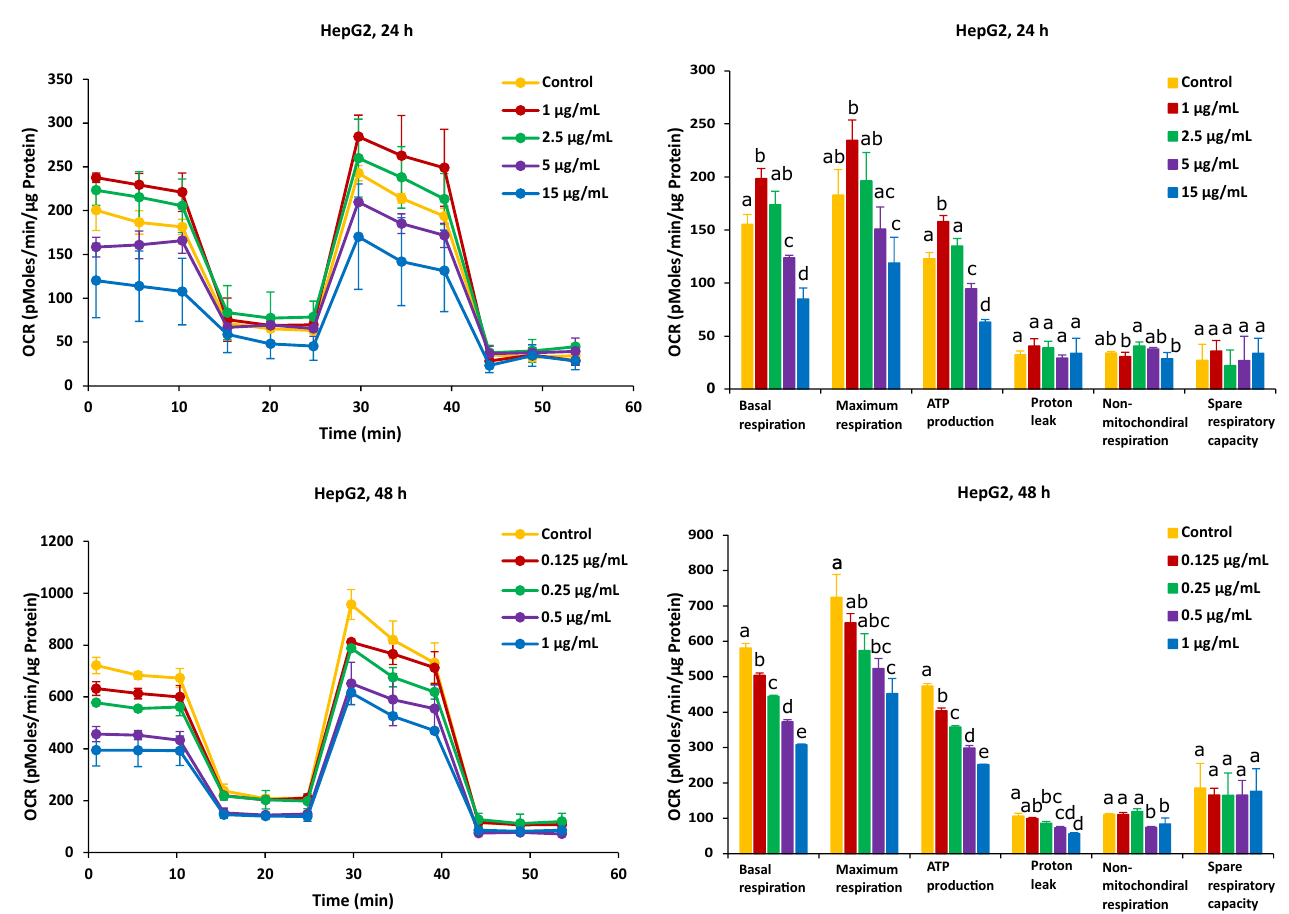
Figure 6. Effect of AFB1 on oxygen consumption rate (OCR) ( left ) and different mitochondrial parameters ( right ) in HepG2 cells after 24 h and 48 h of exposure. Data (at least four technical replicates) are expressed as mean ± standard deviation. Mean values with different letters (a–e) within each mitochondrial parameter indicate significant differences ( p < 0.05) between different AFB1 treatments according to one way ANOVA test followed by Tukey HSD multiple-comparison test as a post hoc